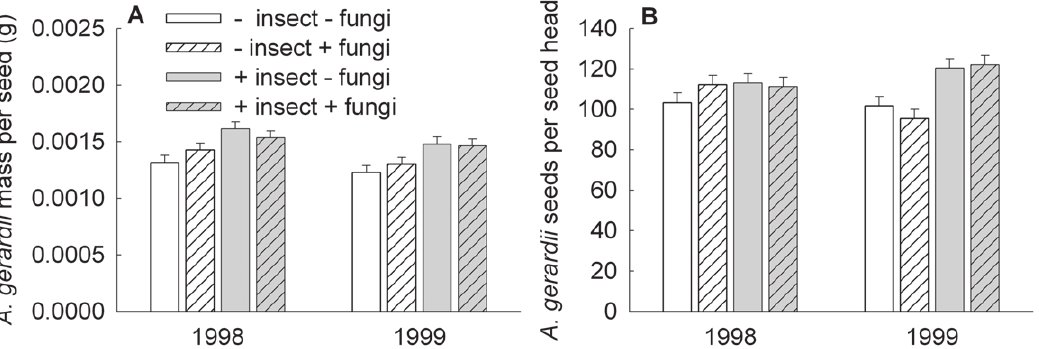
Figure 2. The effects of insecticide, fungicide, and year on additional measures of Andropogongerardii seed production. Effects are shown for (A) mass per seed and (B) seeds per seed head (error bars are + 1 standard error).